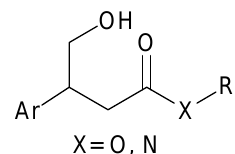
Figure 1. 3-Aryl-4-hydroxybutyrate